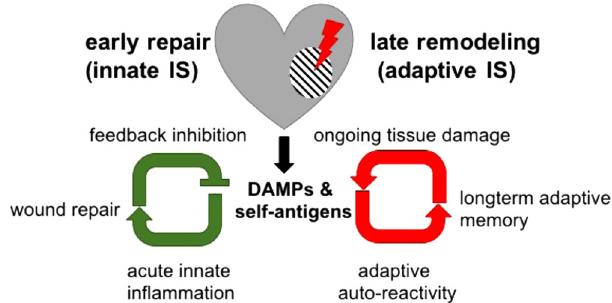
Fig. 1 The role of the innate and adaptive immune system post MI. A MI causes severe tissue damage and the release of DAMPs and cardiac self-antigens such as myosin and troponin. Immediately after injury, DAMPs lead to an acute in fl ammatory response, characterized by the in fl ux of a vast number of innate immune cells, which initiate and orchestrate wound repair. Negative feedback mechanisms activated immediately and the declining availability of DAMPs eventually resolves early in fl ammation. However, in parallel, the release of massive amounts of self- antigens in an in fl ammatory environment breaks tolerance mechan- isms and induces long-lived antigen-speci fi c adaptive immune cells, which cause ongoing autoimmune tissue damage and continuous supply of self-antigen. IS; immune